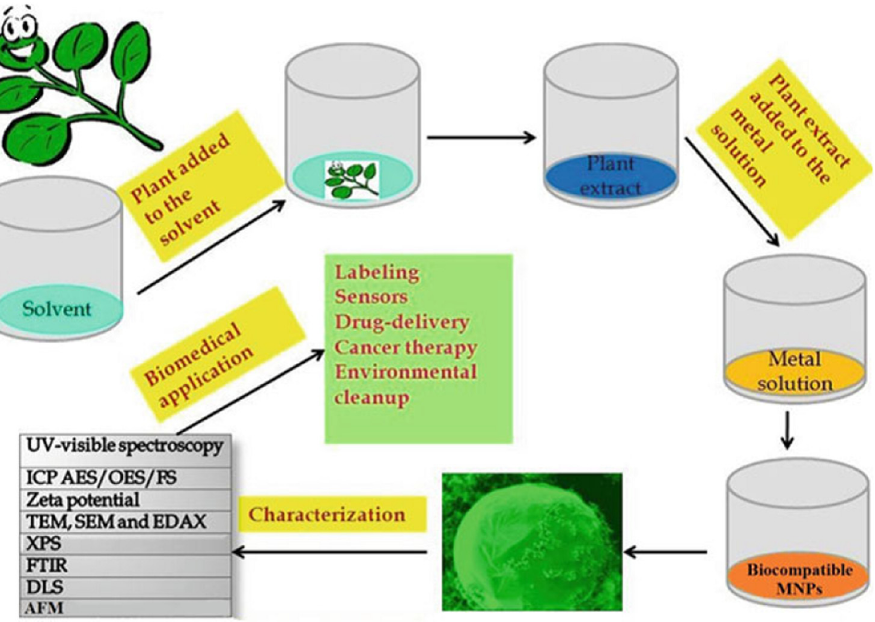
Figure 6: A schematic illustration of plants as a source for the green synthesis of nanoparticles and the properties and biomedical implementation of nanoparticles [ 47 ] .